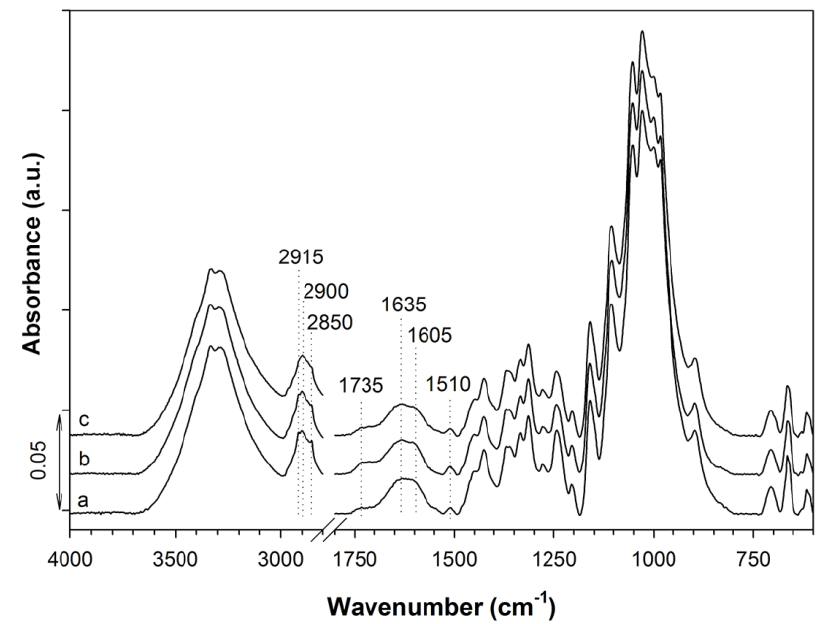
Figure 2. FTIR spectra of ( a ) CP; ( b ) CCP-CHT1; and ( c ) CCP-CHT2 samples.